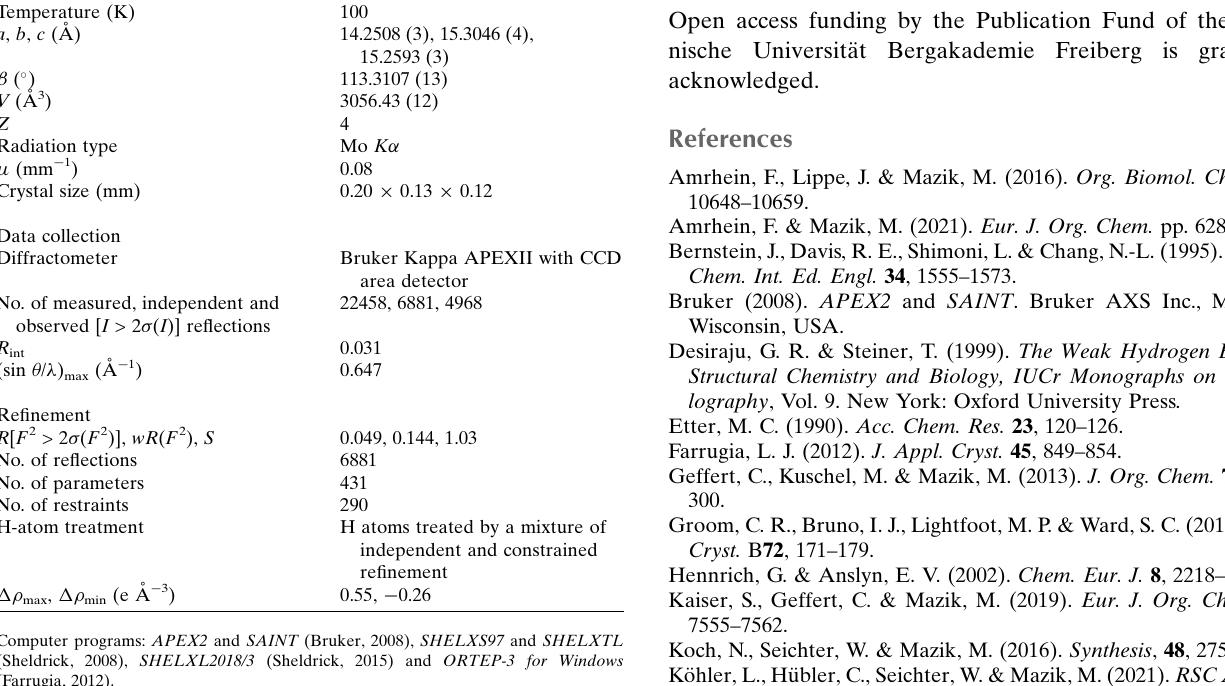
Table 2 Experimental details. Crystal data Chemical